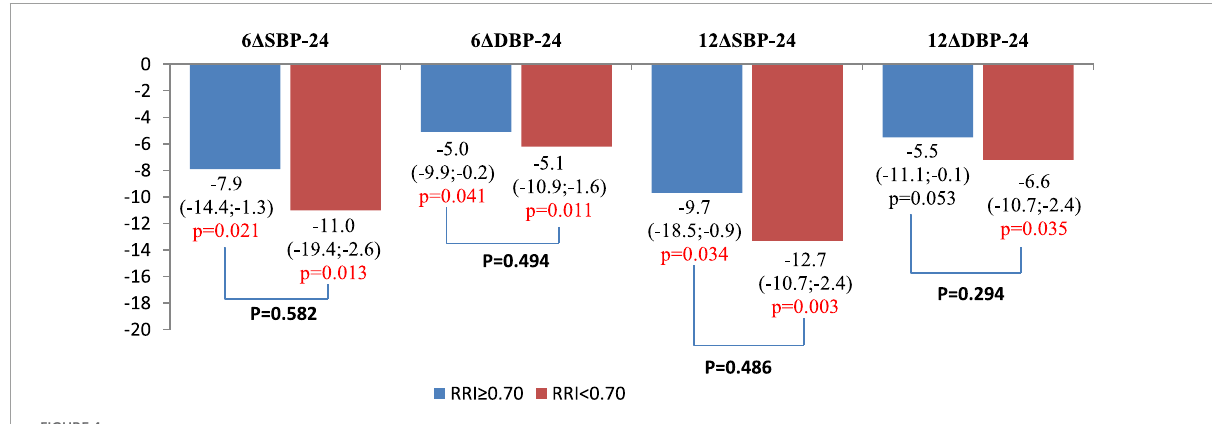
FIGURE4 Comparison of changes in 24-h ambulatory blood pressure (BP) values at 6 and 12 months after renal denervation (RDN). Data are mean and 95% confidence